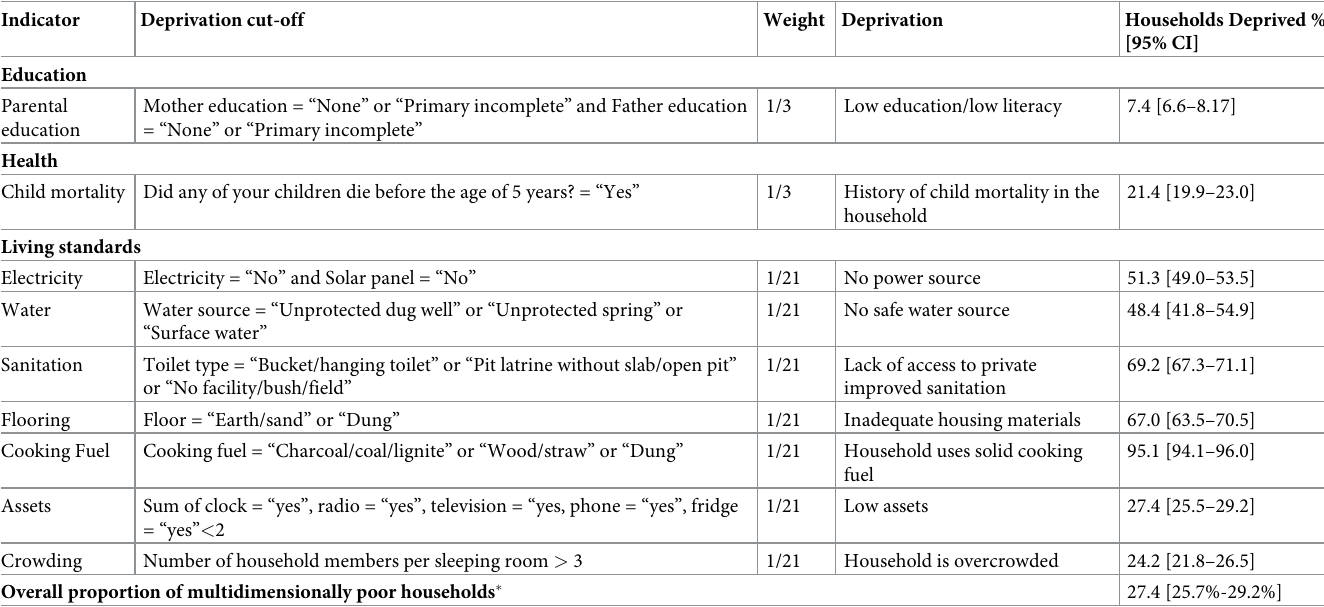
Table 6. Indicators included in the multidimensional poverty